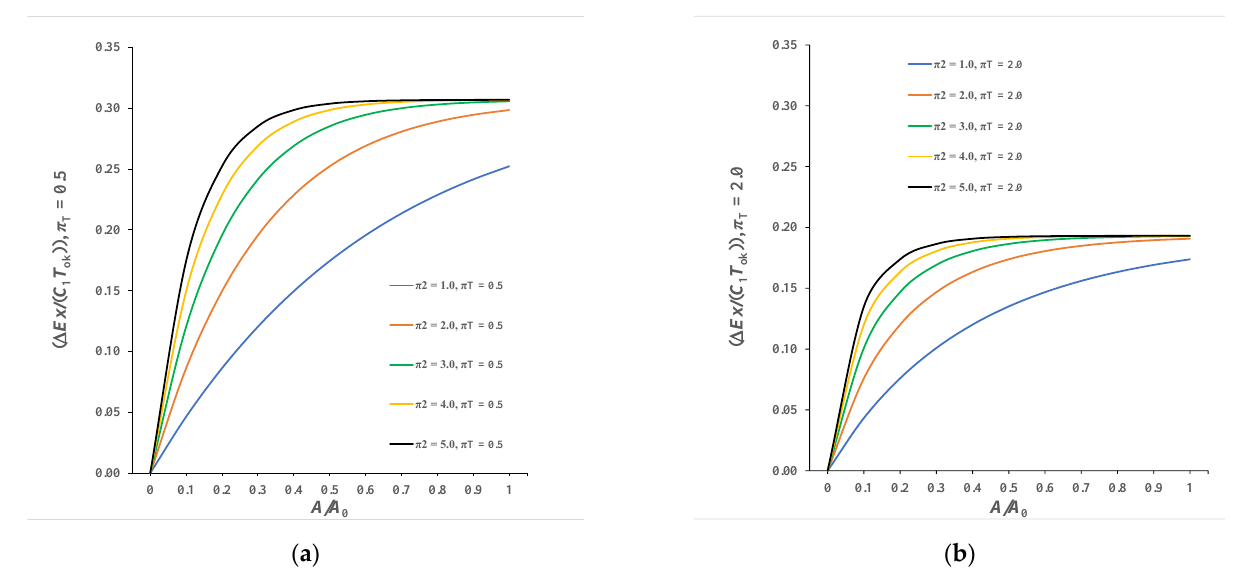
Figure 7. Local exergy destruction of a recuperator for π 3 = 0.0: ( a ) π T = 0.50; ( b ) π T = 2.0.